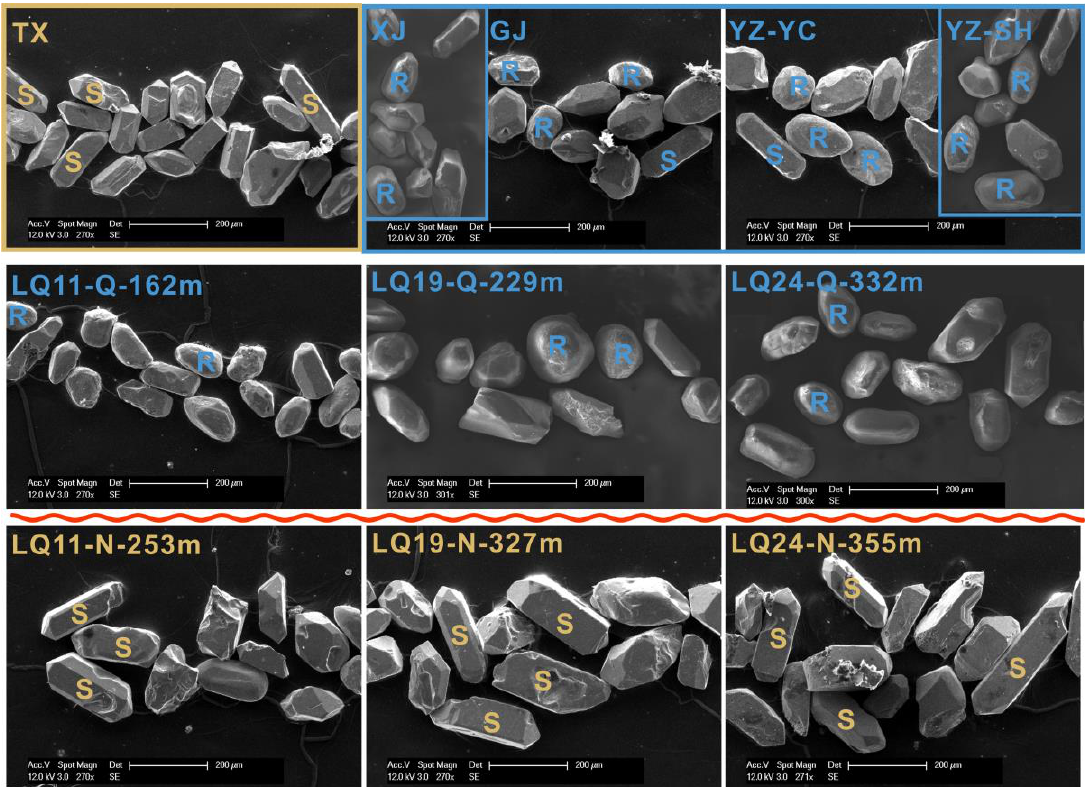
Figure 7. Zircon morphology of the Yangtze Delta and Modern River measured by a scanning electron microscope. S = Slender, R = Rounded, Q = Quaternary, N = Pliocene. In the Pliocene sediment of the Yangtze Delta, zircon grains show angular-subangular euhedral crystals, which is similar to that of the local rivers. In the Quaternary samples, the increase of the rounded and stubbed zircon is similar to the Yangtze mainstream and Middle tributaries. Please see Figure 1 for explanation of the abbreviations of capital letters.